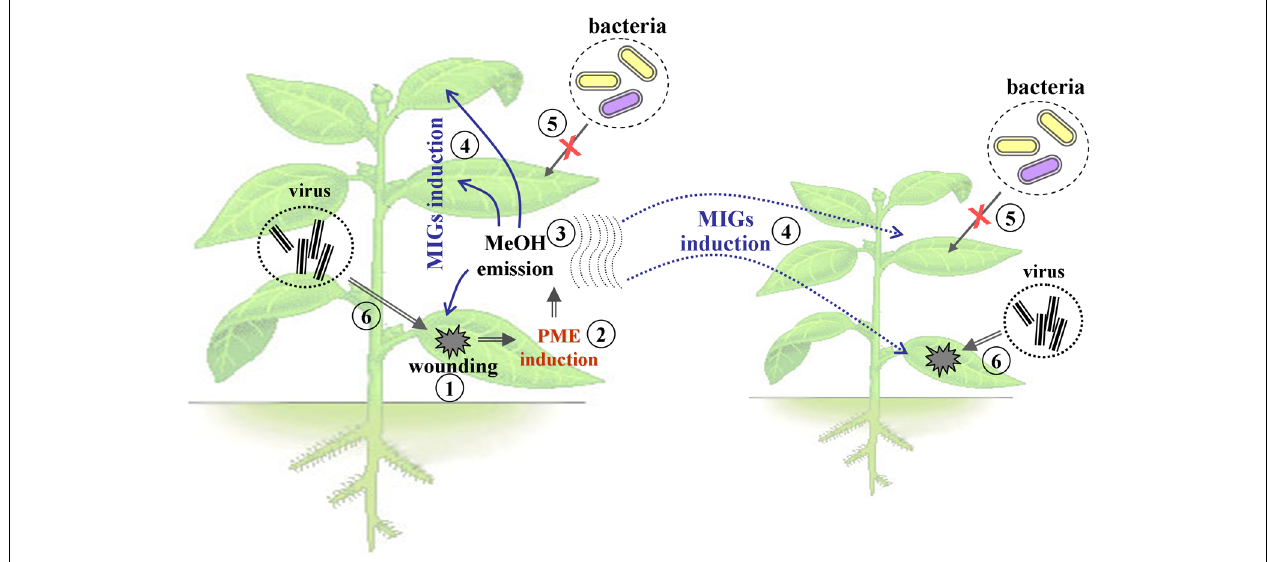
FIGURE 1 |The model of the effects of methanol emitted by the damaged plant. Mechanical damage to the leaves of the plant (1), leads to an increase in the expression level of PME (2), and induction of the release of gaseous MeOH (3). Emitted MeOH causes priming of adjacent leaves